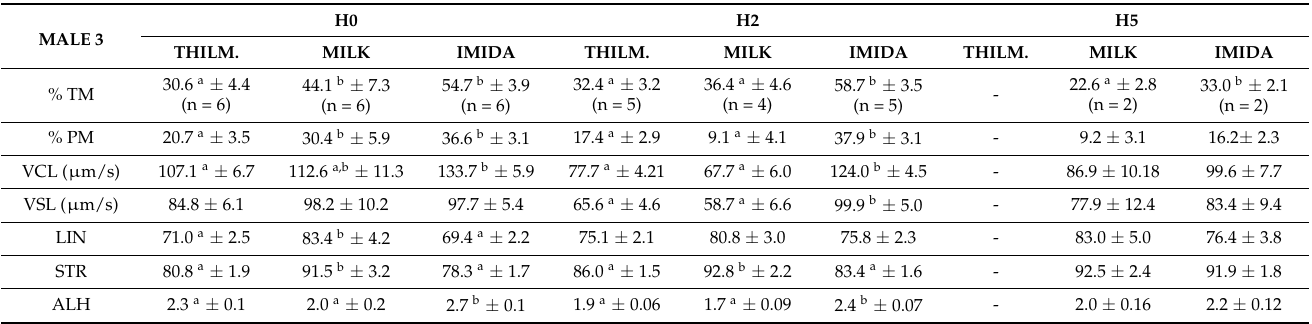
Table 8. Average semen parameters obtained by CASA system for male 3 in the resistance test, according to extender (if there is no number: no motile spermatozoa reached that evaluation time with that extender).